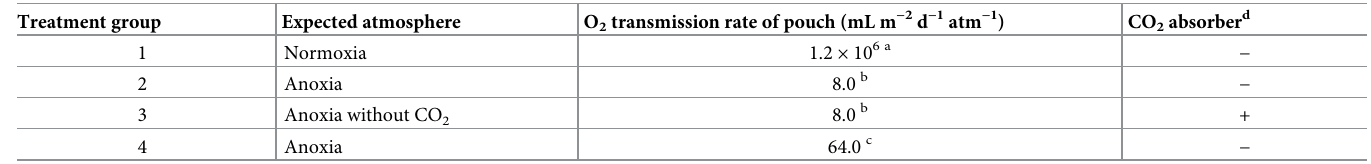
The mean values were calculated for each treatment group ( n = 3 replicates per treatment) and the statistical significance of differences among treatments was tested using Tukey’s honest Table 2. Treatments used in the present